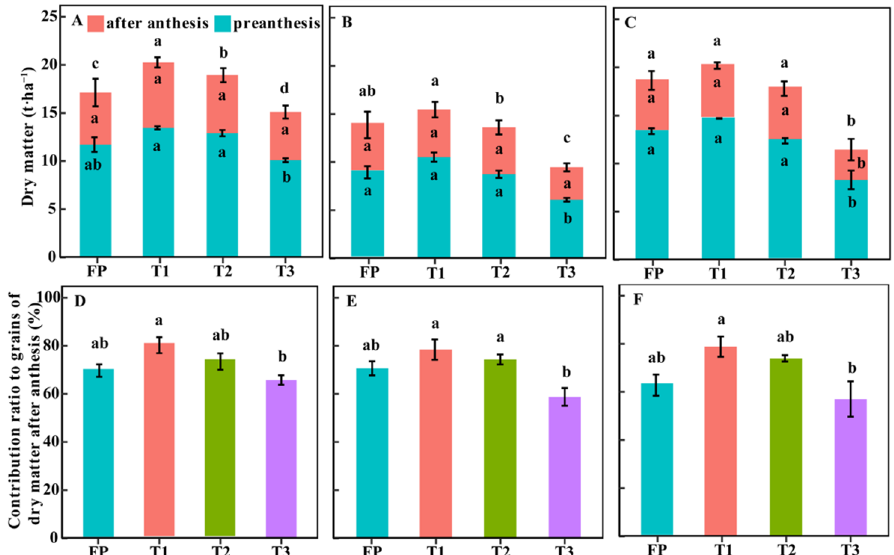
Figure 6. Dry matter at anthesis, after anthesis ( A – C ) and contribution ratio of dry matter after anthesis to grain ( D – F ) under different treatments in 2016–2017 ( A and D ), 2017–2018 ( B and E ), and 2018–2019 ( C and F ) growing seasons. In Figure A – C , the bottom half of the column is the dry matter pre-anthesis, shown in blue color, while the top half of the column is the dry matter after anthesis, shown in red color. Different letters in the figure indicate statistical differences among treatments (LSD p < 0.05 ).